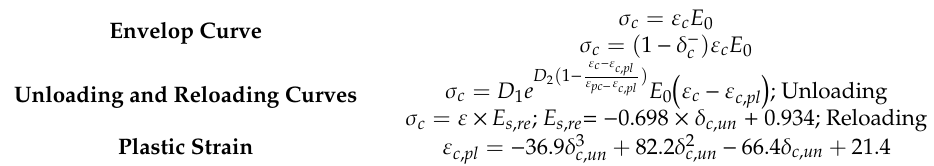
Table 4. Constitutive model for masonry under cyclic compression: Sima et al. [27].